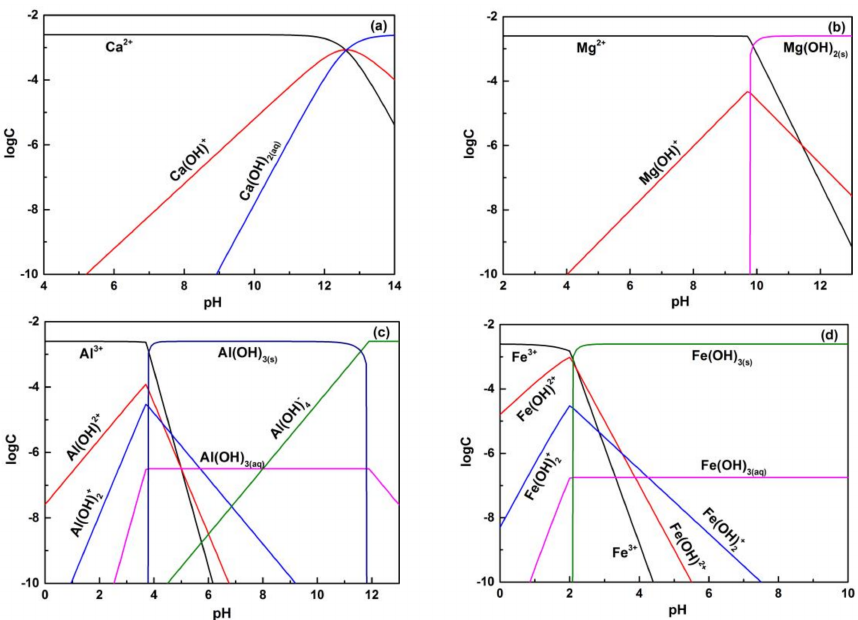
Figure 5. The logC–pH diagram for hydrolysis species of ( a ) Ca 2+ ; ( b ) Mg 2+ ; ( c ) Al 3+ ; ( d ) Fe 3+ with the initial ionic concentration of 2.5 × 10 − 3